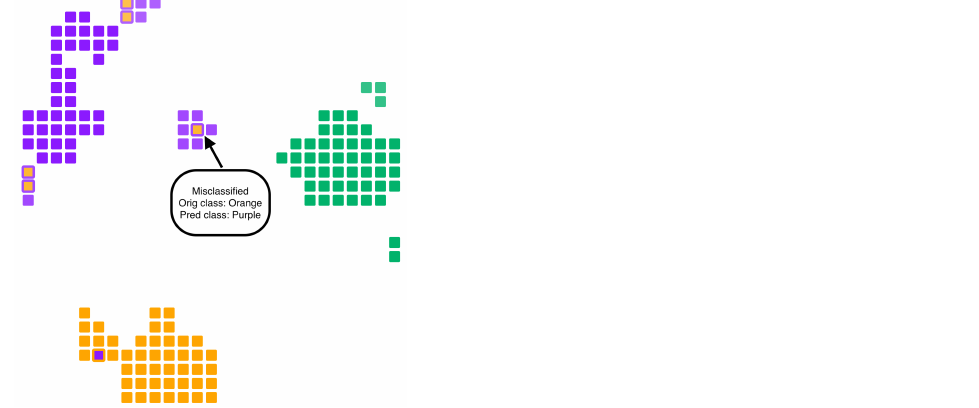
Figure 2. Instance View: Represents misclassified instances, decision boundary between the two classes and